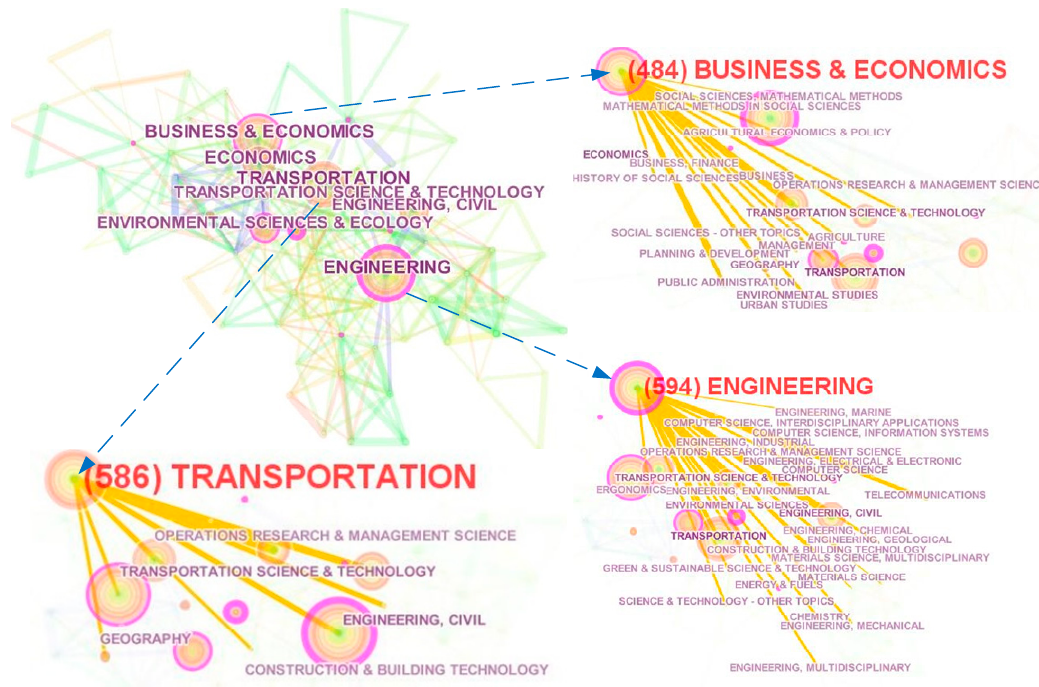
Figure 8. Inter-disciplinary co-occurring network of the literature.